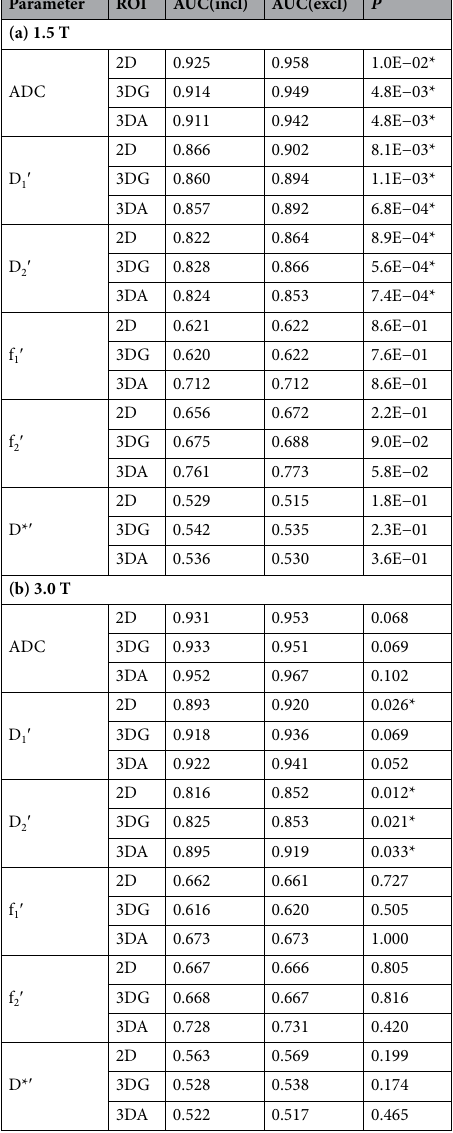
Table 5. Comparison of AUC values of the ROC curves obtained from ROIs including (incl) and excluding (excl) centrally deviating areas like necrosis, cystic components or scars (see Table 1) at 1.5 T (a) and 3.0 T (b). AUC—area under the curve. *marks significant results, P — p